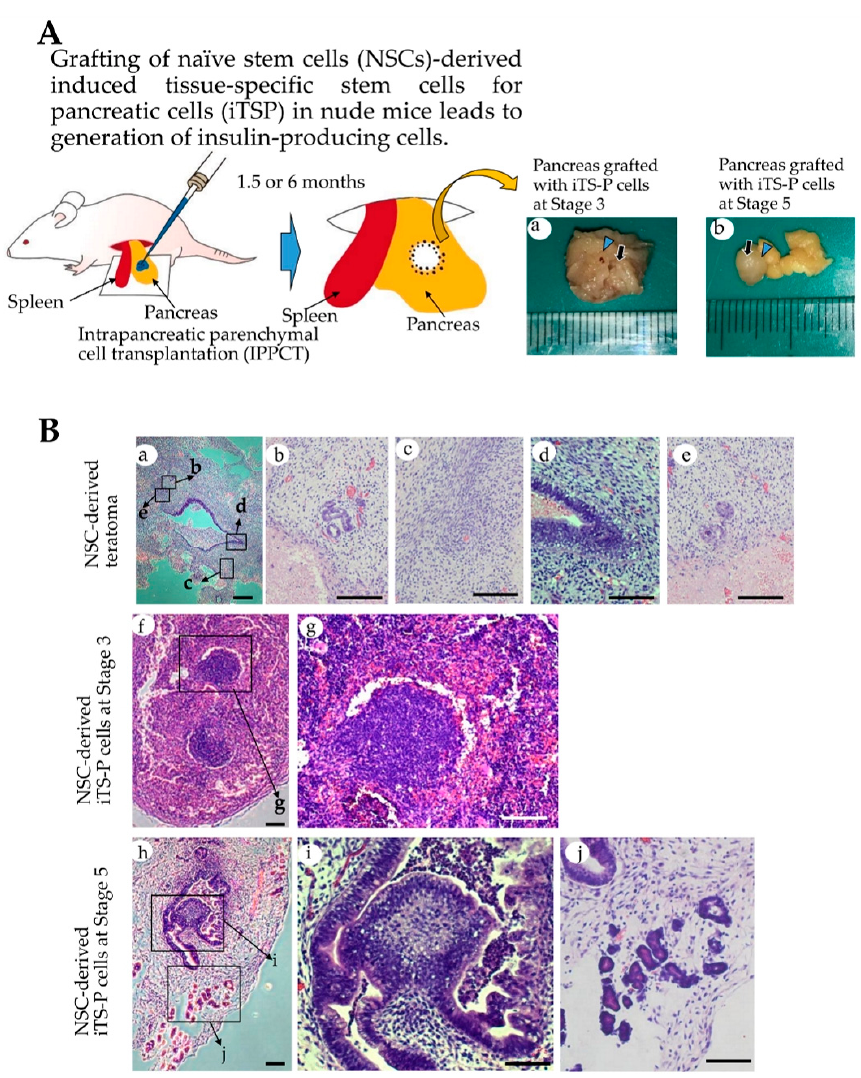
Figure 4. In vivo teratoma formation assay. ( A ): Schematic representation of intrapancreatic parenchymal cell transplantation (IPPCT). Under anesthesia, the spleen and pancreas were pulled out from the left dorsal side of a nude mouse. Cells or cell aggregates were then introduced into pancreatic parenchyma, using a glass micropipette (connected to the mouthpiece) under a dissecting microscope. After growth for 1.5 or 6 months, the growing solid tumor or small lump, generated in the pancreas, were isolated and then subjected to cryostat sectioning. In the right panel, photographs of the pancreas isolated after grafting with induced tissue-specific stem cells for pancreatic cells (iTS-P) at Stage 3 and 5 are shown. Small lump (indicated by arrow), surround by normal-looking pancreas (arrowhead), was discernible in the sample grafted with iTS-P at Stage 3. In the sample grafted with iTS-P at Stage 5, the lump (indicated by arrow) was separated from normal-looking pancreas (arrowhead). ( B ): Histological analysis of the dissected solid tumor or the small lump isolated from the pancreas by hematoxylin-eosin staining (a–e). Solid tumor (teratoma) isolated 1.5 months after inoculation of naïve stem cells (NSCs). Magnified images in b-e are derived from boxes in (a,f,g). Lump isolated 6 months after inoculation of iTS-P at Stage 3. Magnified image in g is derived from a box in (f,h–j). Lump isolated 6 months after inoculation of iTS-P at Stage 5. Magnified images in (i) and (j) are derived from boxes in h. Bar = 100 µm.